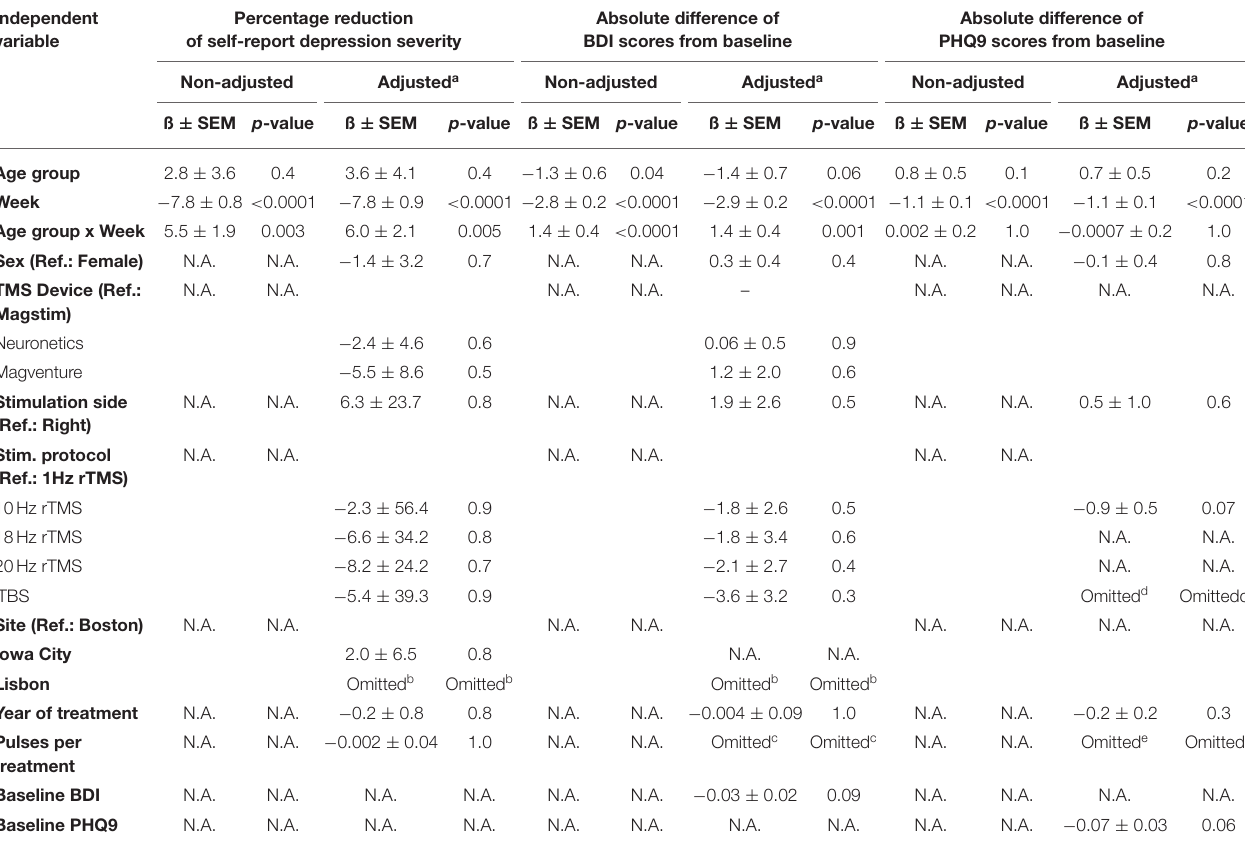
TABLE 2 | Statistical models of antidepressant response across transcranial magnetic stimulation treatment. Independent Percentage reduction Absolute difference of Absolute difference of variable of self-report depression severity BDI scores from baseline PHQ9 scores from baseline Non-adjusted Adjusted a Non-adjusted Adjusted a Non-adjusted Adjusted a ß ± SEM p -value ß ± SEM p -value ß ± SEM p -value ß ± SEM p -value ß ± SEM p -value ß ± SEM p